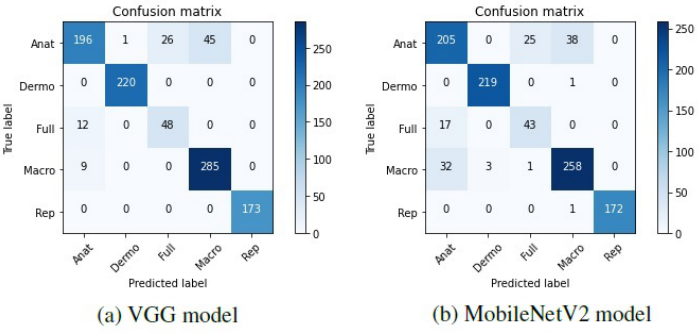
Figure 3. Confusion matrices of the base models tested on Task